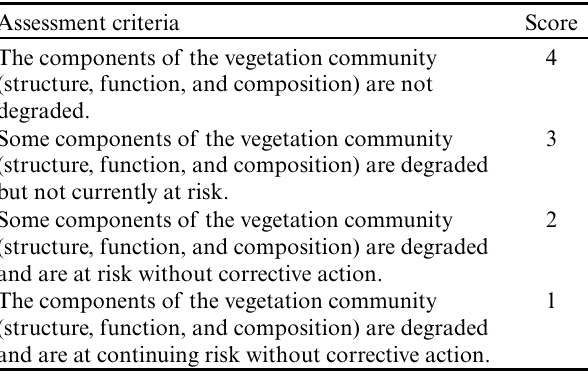
Table 1 . The assessment criteria against which protected area practitioners were asked to assess the condition of